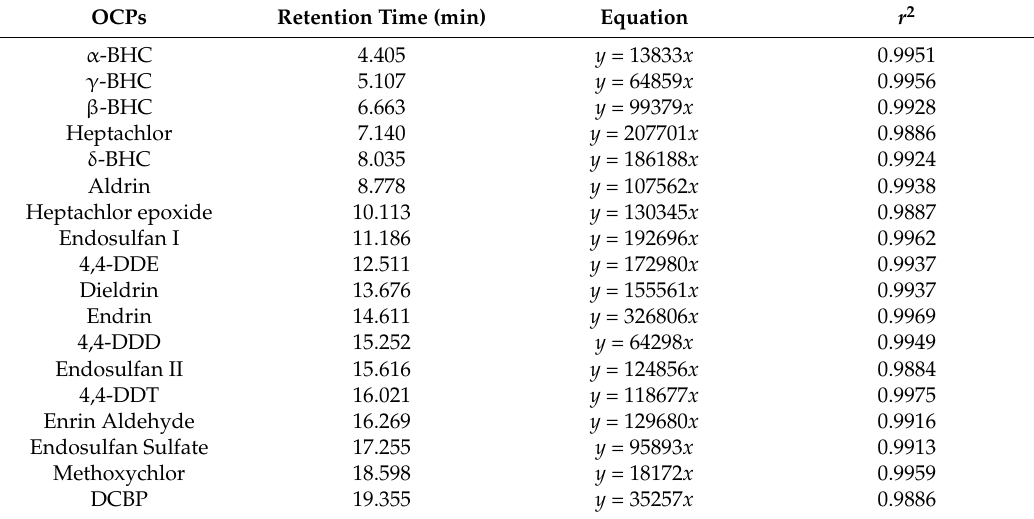
Table 2. Retention time, equation, and correlation coefficient ( r 2 ) of